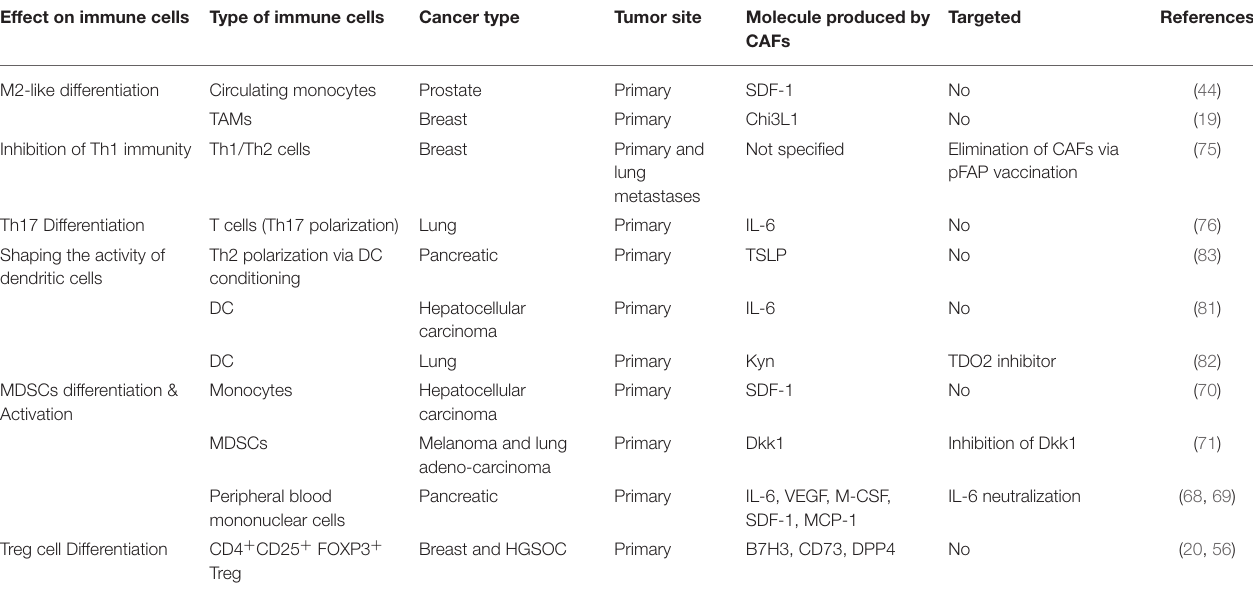
TABLE 2 | CAF-mediated modulation of immune cell